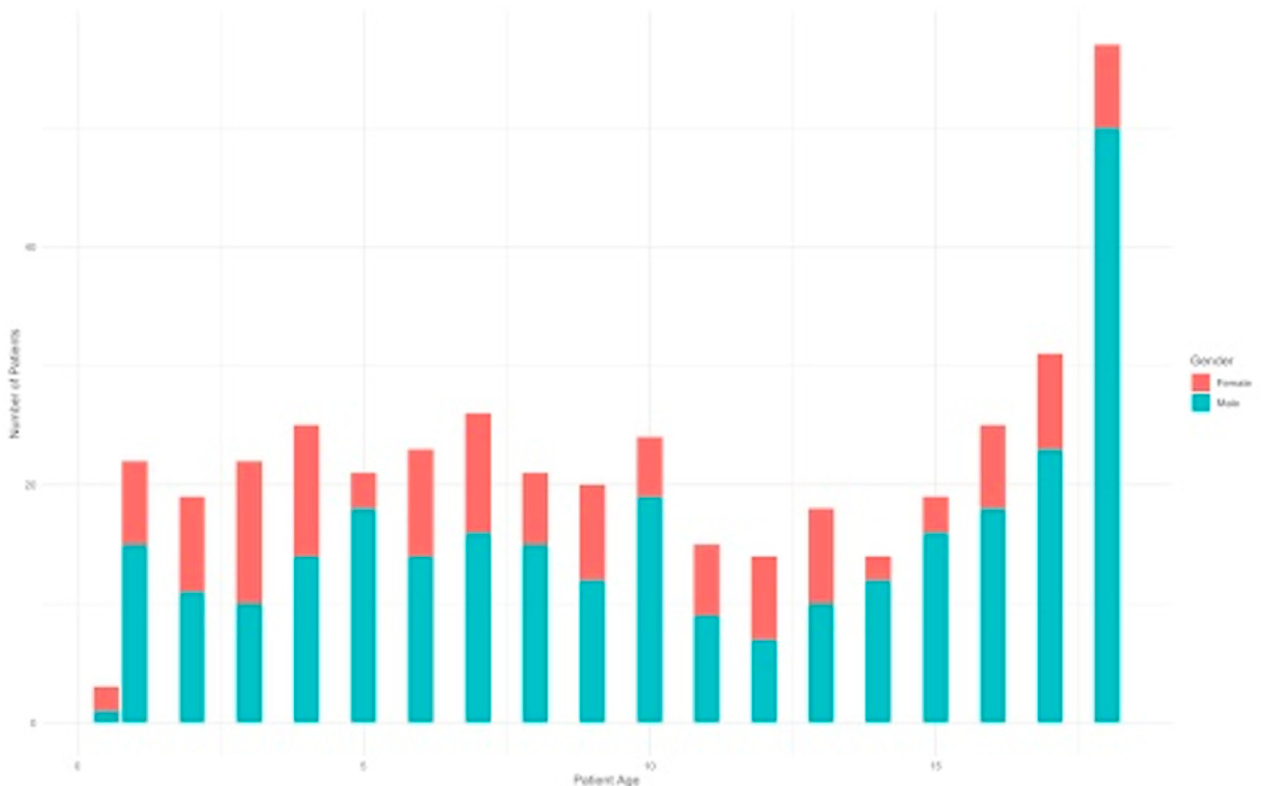
Fig 1. Pediatric patients by age and gender. The frequency of pediatric patients at each age broken down into the number of males and females of that age.